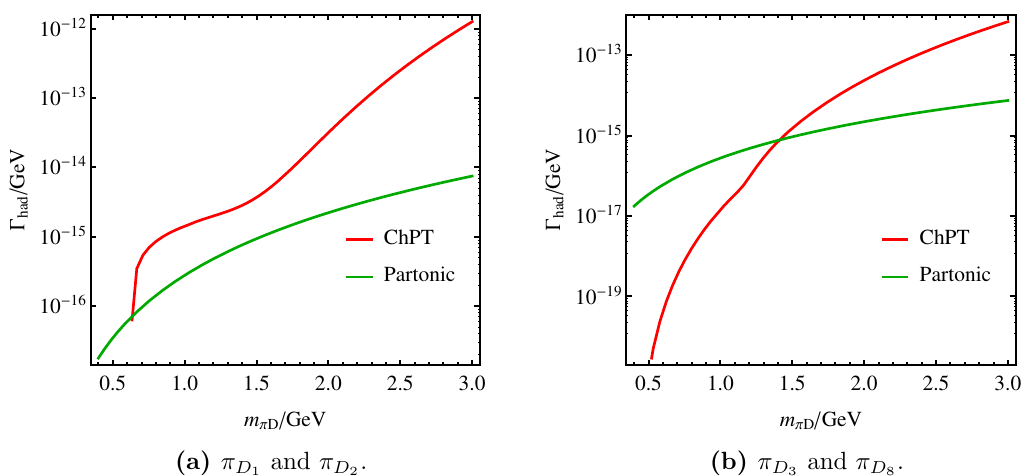
(b) (cid:25) D 3 and (cid:25) D 8 .